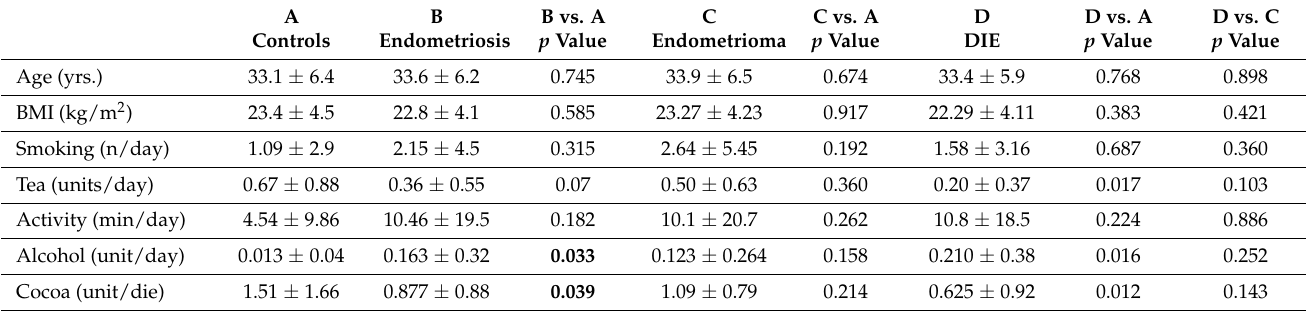
DIE: Deep Infiltarting Endometriosis; Bold values—significant values ( p value < 0.05). Women with endometriosis showed a higher daily intake of alcohol (0.163 ± 0.322 vs. 0.013 ± 0.04 units/day; p = 0.033) and a lower intake of cocoa (0.877 ± 0.88 vs. 1.59 ± 1.66 units/day, p = 0.039). These differences, along with a lower tea intake (0.20 ± 0.37 vs. 0.67 ± 0.88 units/day; p = 0.017), were significant only in women with DIE, while they did not reach statistical significance in women in the Endometrioma group (Table 1).